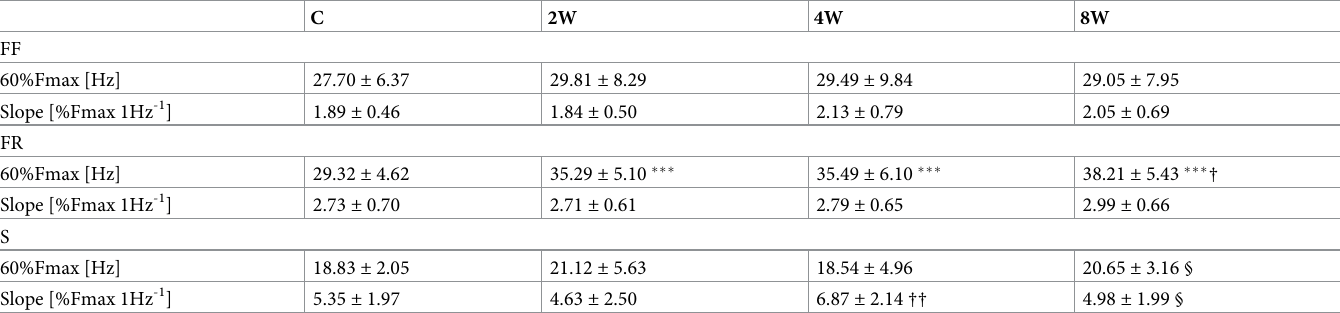
Table 2. Properties of the force-frequency relationship in studied motor units in control and trained animals.